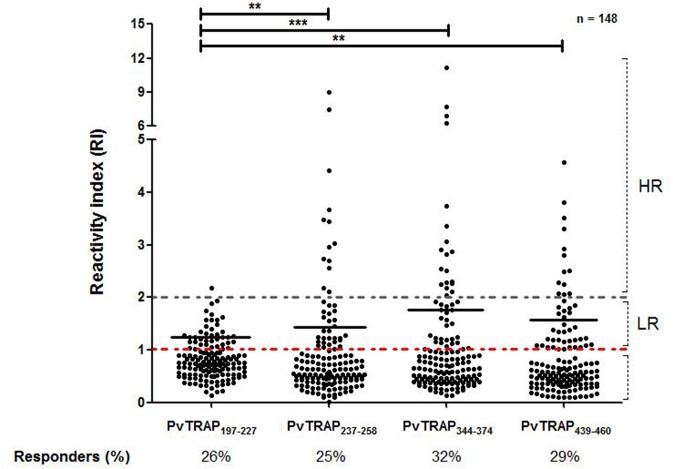
Frequency of responders for tested peptides and mean of RI among responders (low responders and high responders). Each point represents an individual RI against PvTRAP and the red traced line represents the cutoff that separates responders and non-responders. The gray dotted line separates the individuals tested in low responders (LR) (RI>1 and RI<2) and high responders (HR) (RI>2). Peptide PvTRAPR197−H227presented a lower median of RIthan peptide PvTRAPE237−T258 (p = 0.0049), peptide PvTRAPP344−G374 (p < 0.0001), or peptide PvTRAPE439−K454 (p = 0.0073).